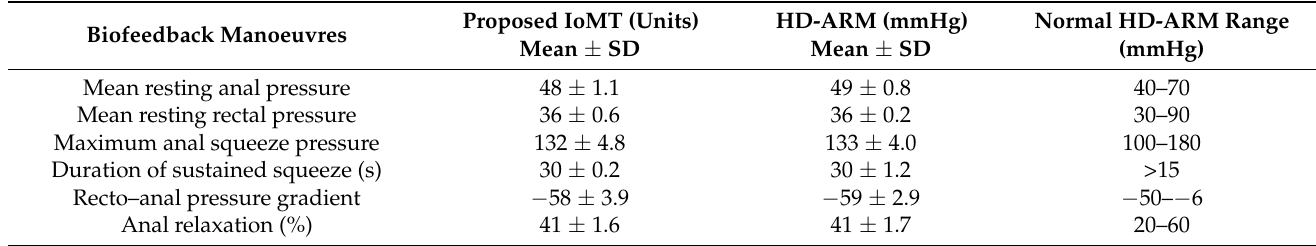
Table 3. Comparison of anorectal biofeedback parameters with proposed IoMT and high-definition anorectal manometry from a healthy